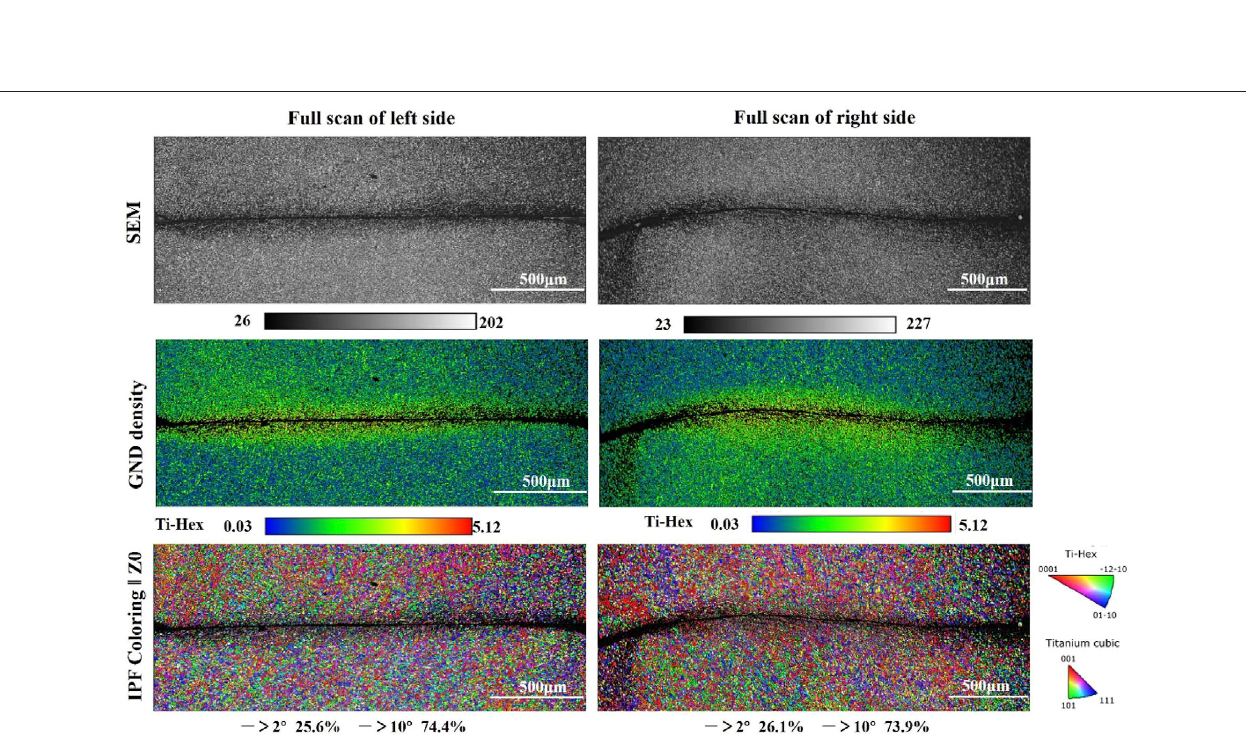
FIGURE 8 | The features of the hat-shaped sample in terms of back scattering (BC), geometrically necessary dislocation (GND) map, and the coupling analysis of inverse pole fi gure and grain boundary map (IPF + GB) at strain rate of 2.0 × 10 4 s − 1 .